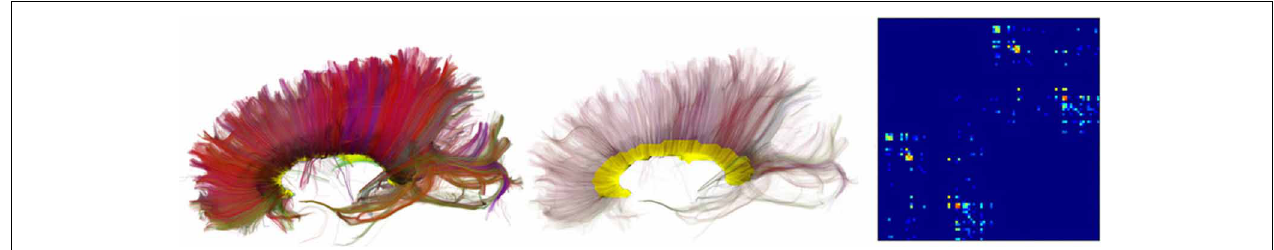
FIGURE 8 | Left: Streamlines intersecting a mask in the corpus callosum (CC). Middle: Showing the streamlines with semi-transparency to make it easy to see the mask (yellow color). Right: Connectivity matrix of the CC streamlines that connect 89 cortical regions. A detailed tutorial which explains how it is possible to create similar connectivity matrices with your data is available at Dipy’s